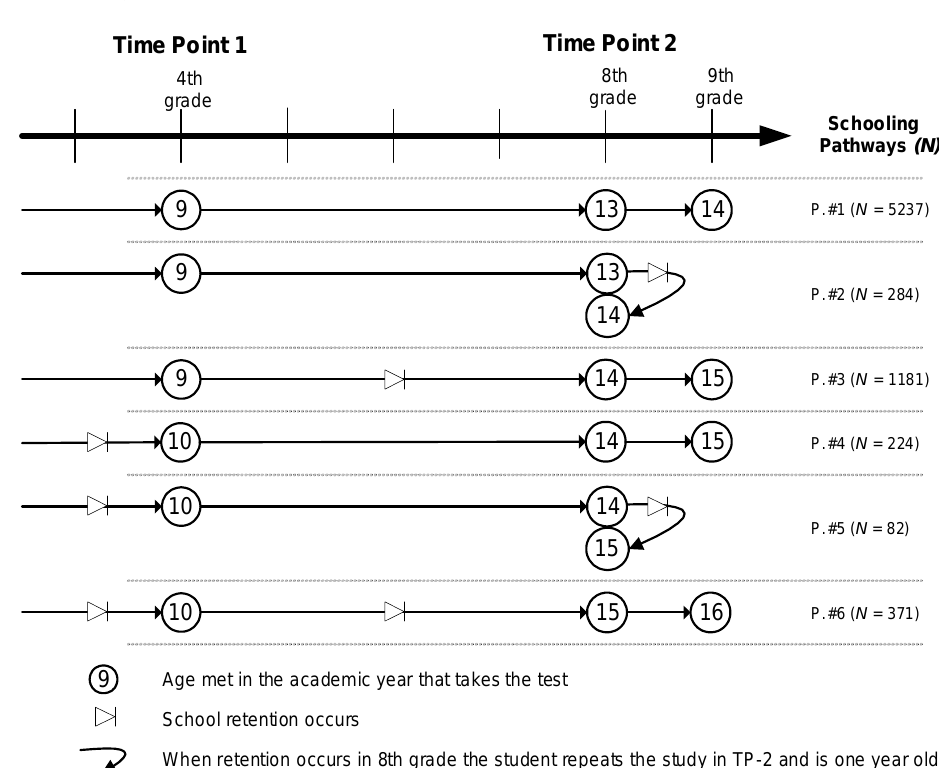
Figure 1. Schooling pathways.